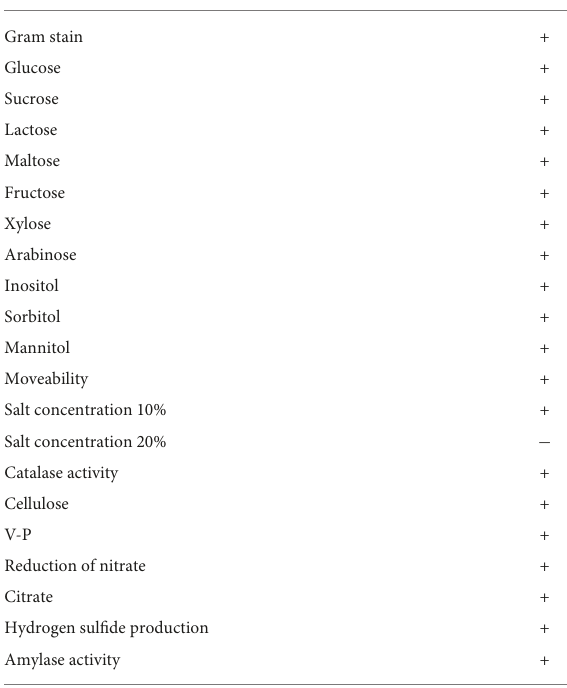
TABLE 1 Identification of the physiological characteristics of Bacillus halotolerans